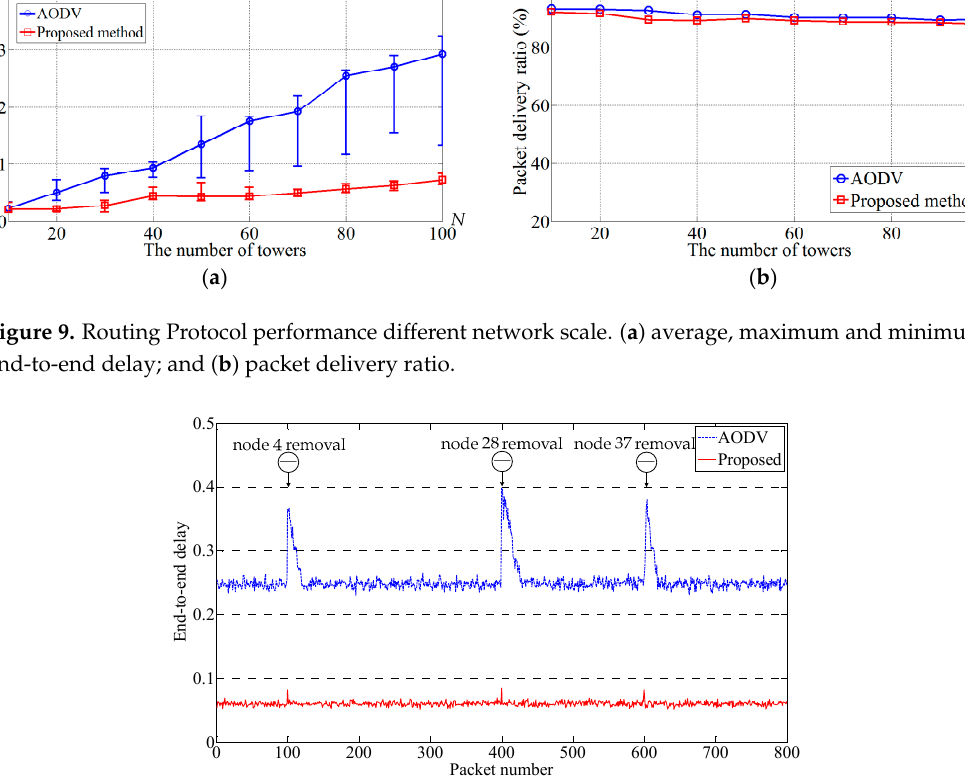
Figure 10. Routing protocol performance with node removal.